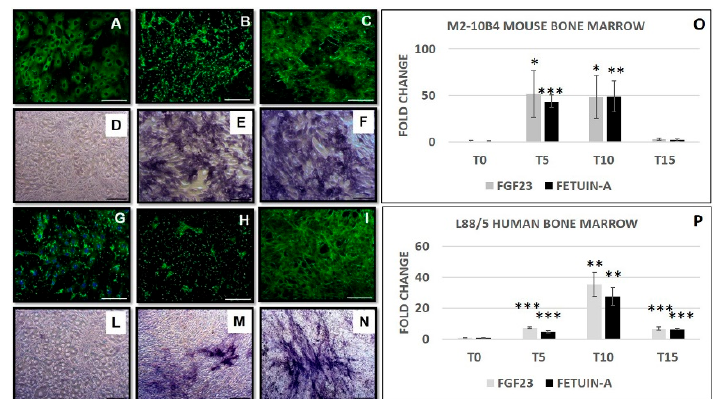
Figure 5. COLI α I and ALP staining in mouse M2-10B4 ( A – C )/( D – F ) and in human L88/5 ( G – I )/( L – N ) bone marrow cells from T0 to T10 days from the osteogenic induction. qRT-PCR of Fetuin-A mRNA expression and FGF23 in M2-10B4 ( O ) and L88/5 bone marrow cells ( P ) from T0 to T15 days from the osteo-differentiation. Asterisks indicate significant differences versus M2-10B4 and L88/5 T0: * p < 0.05, ** p < 0.01, *** p < 0.001. Scale bar = 100 µ m ( A – C / G – I ), 200 µ m ( D – F / L – N ).